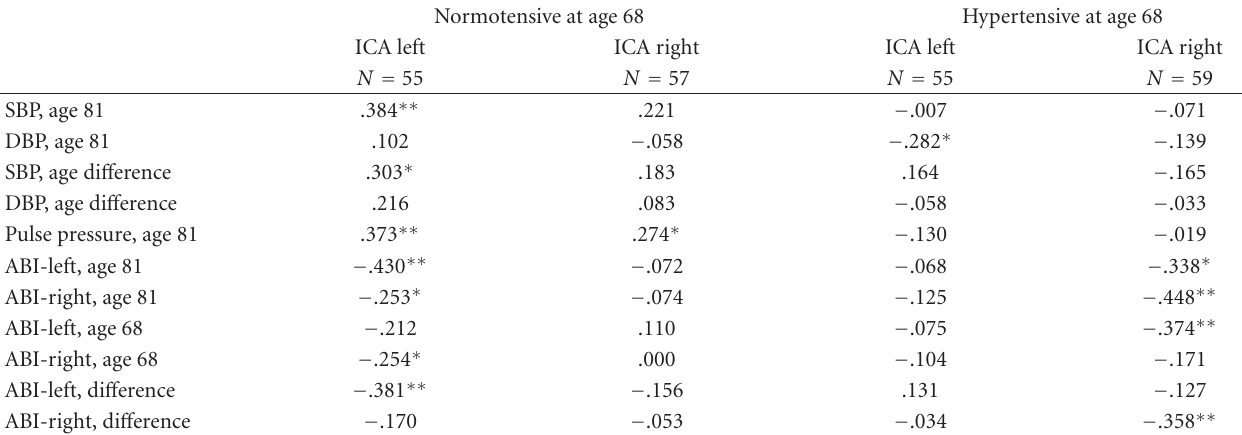
Table 4: Correlation coe ffi cients between peak systolic velocity in right/left ICA and blood pressure trend. Ankle-brachial index (ABI) at ages 68, 81, and its time di ff erence. Analyses performed in study subjects defined as normotensive and hypertensive at age 68. Normotensive at age 68